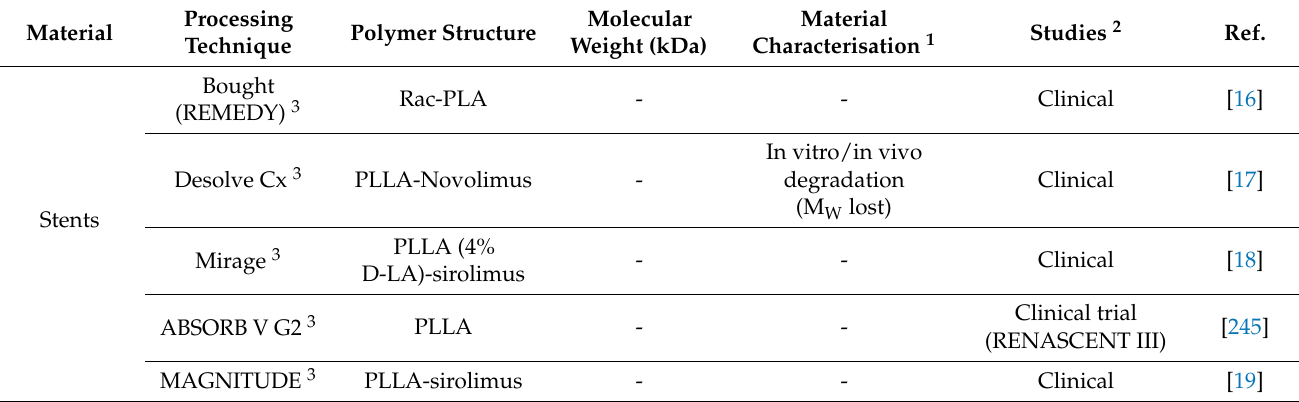
Table 5. Summary of PLA-derivative